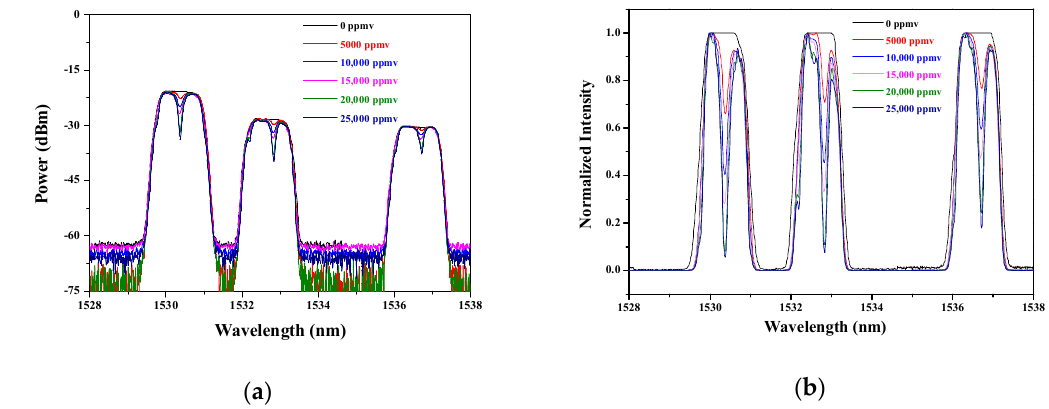
Figure 9. ( a ) Absorption spectra with different concentrations; ( b ) absorption spectra with normalized intensity.